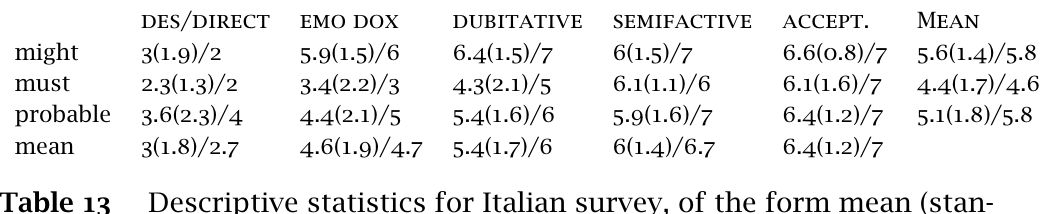
Descriptive statistics for Italian survey, of the form mean (stan- dard